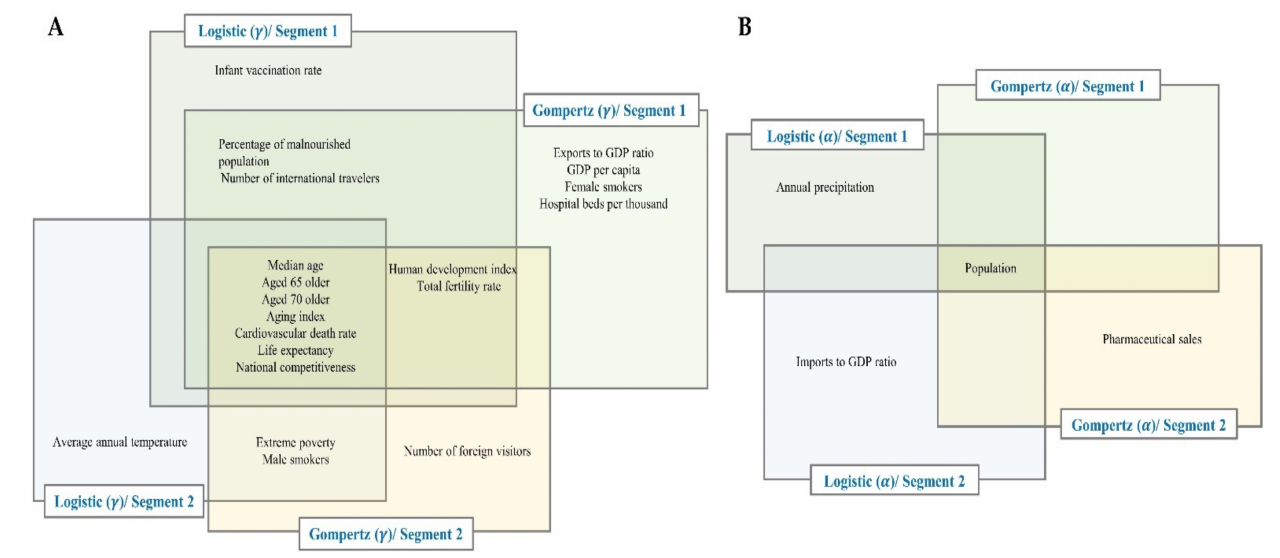
Figure 7. Significant national factors with number of maximum predicted cumulative confirmed cases ( α ) and rate of spread of COVID-19 ( γ ). Median age, being aged 65 or older, being aged 70 or older, aging index, cardiovascular death rate, life expectancy, and national competitiveness were the only national factors that were found to be significant across the two models and segments ( A ). Population was significant across the two models and segments ( B ) (see Figure S11 for significant national factors with β